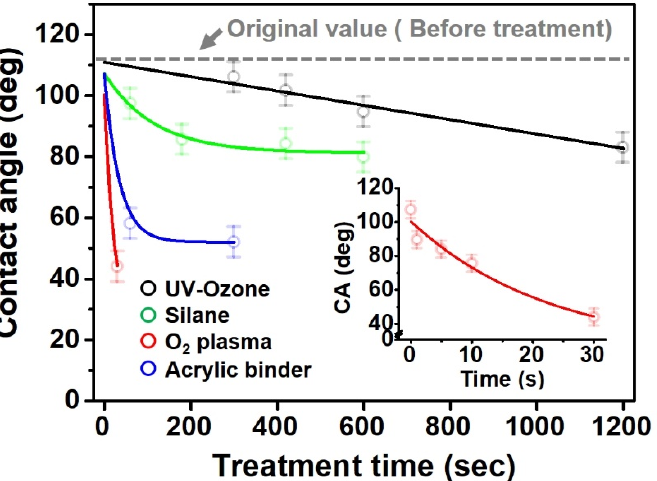
Figure 6. Contact angle change as a function of surface modification types and time for the recycled plastic film-based